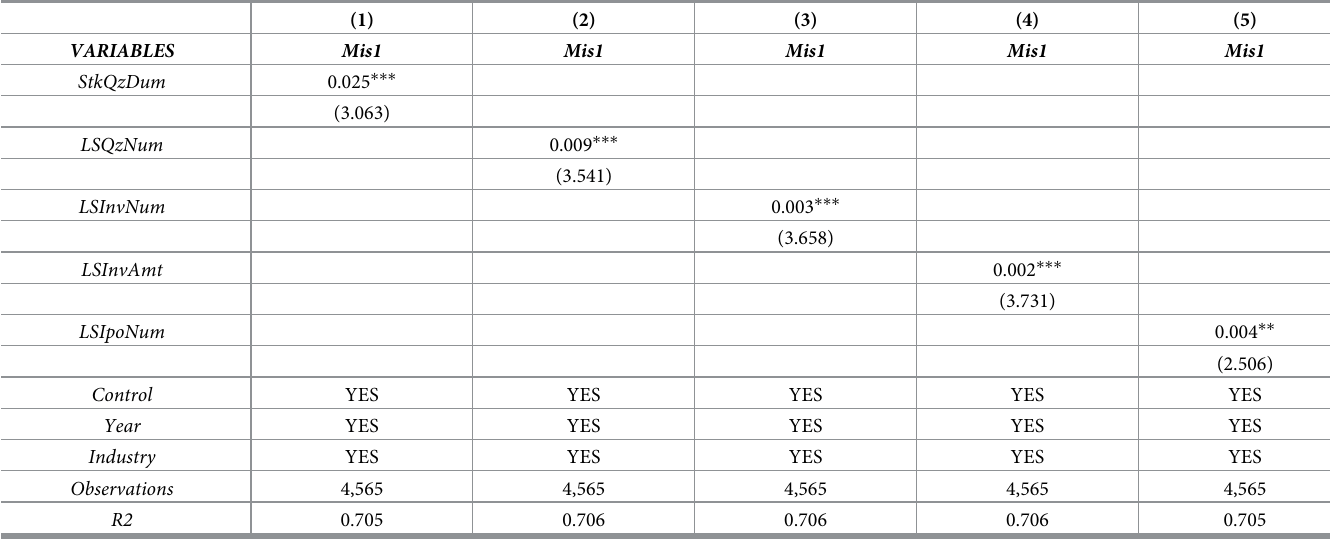
Table 15. VC Quan Zi and asset mispricing (positive)—Adding other control